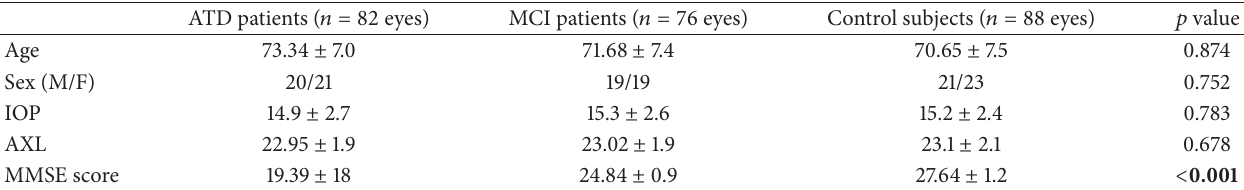
Table 1: Demographic and clinical characteristics of the study subjects.